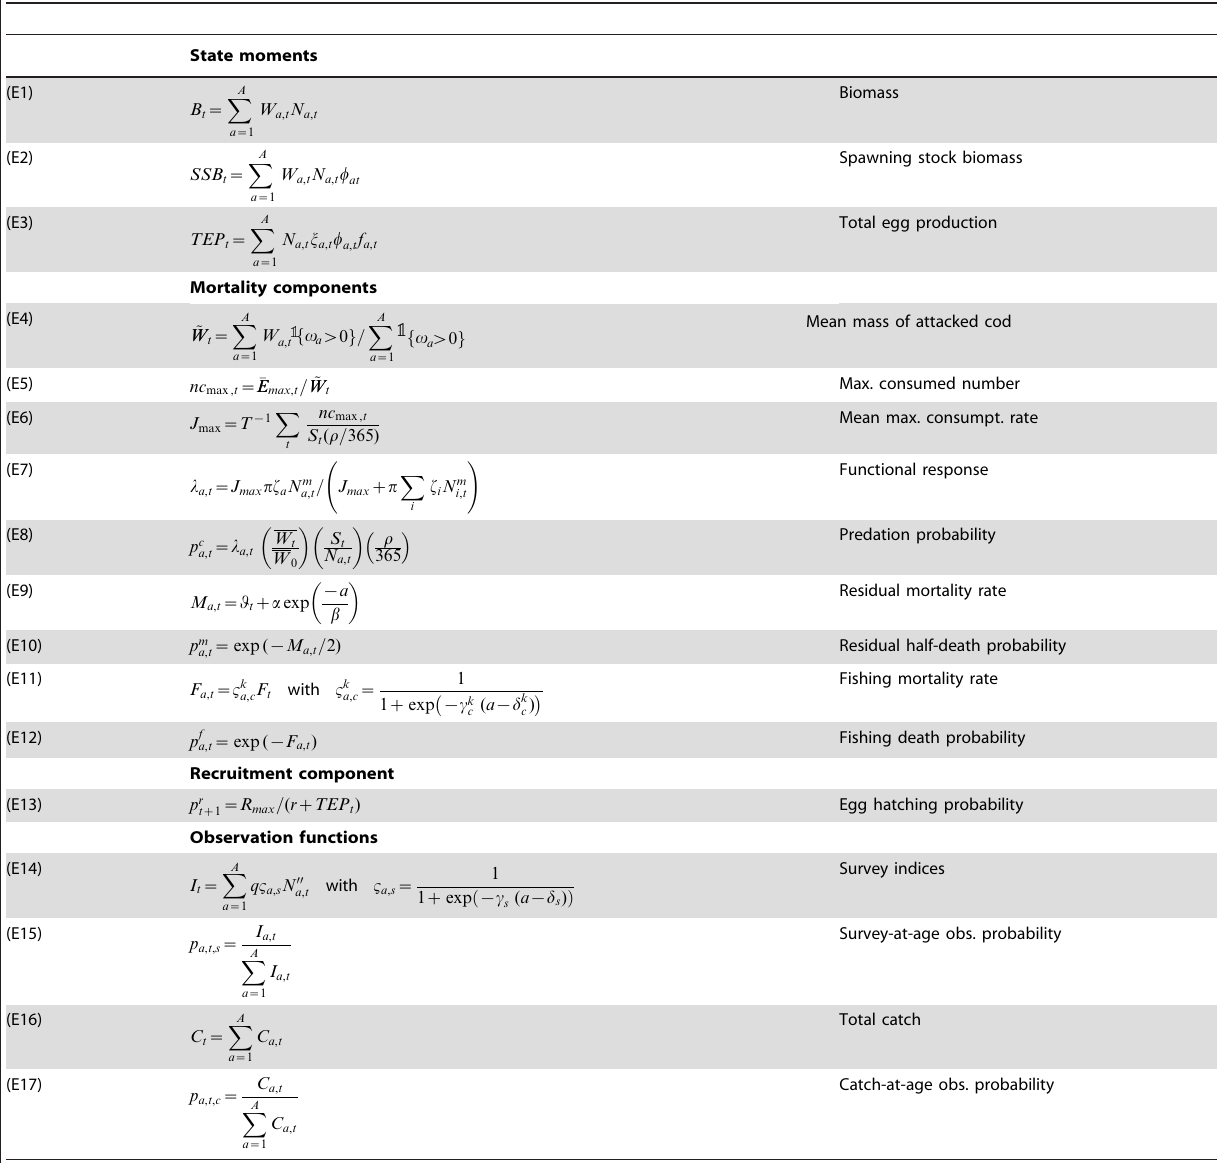
Table 2. Process components, observation functions and associated equations in the SIMCAB model. Notations a , t , s , c index age, year, survey, and commercial, respectively. The term A is the indicator function of event A